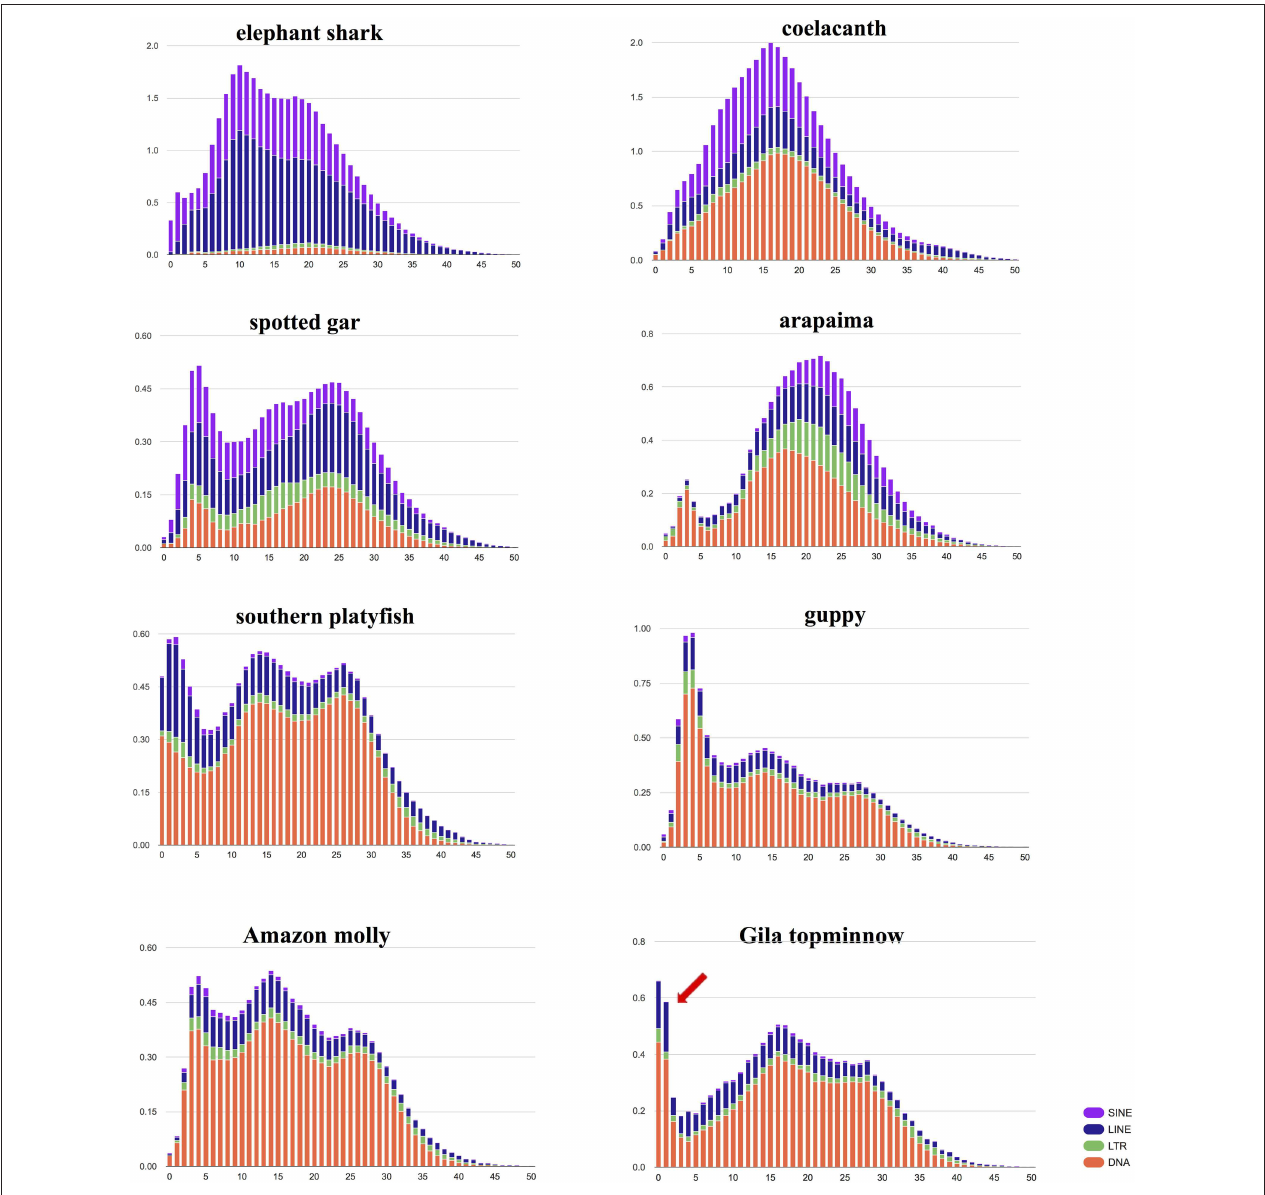
FIGURE 1 | Interspersed repeat landscape. The interspersed repeat landscape, revealing the copy-divergence analysis of Transposable Elements (TE) classes, based on Kimura distances. Percentages of the in genome represented by TEs (Y-axis) are clustered based on their Kimura values (X-axis; K-values from 0 to 50; arbitrary values). Older copies are located on the right side of the graphs while rather recent copies are located on the left side. Arrow indicates the very recent (possibly ongoing) expansion of TE in the Gila topminnow. P. occidentalis (Camacho et al., 2009). Based on the BLAST raw score, H-score, defined as score (Gene1Gene2)/max [score (Gene1Gene1), score (Gene2Gene2)] (Cho et al., 2013), was calculated to evaluate the sequence similarity between any of two genes. Then with H-scores and L. oculatus set as the outgroup, genes were clustered into groups using Hcluster_sg (Ruan et al., 2007). Third, for each group, a gene tree was reconstructed in the guild of species tree using TreeBeST (Ponting, 2007). Finally, according to the tree, genes were assigned as “XtoX” orthologs to each other (X refers to a positive